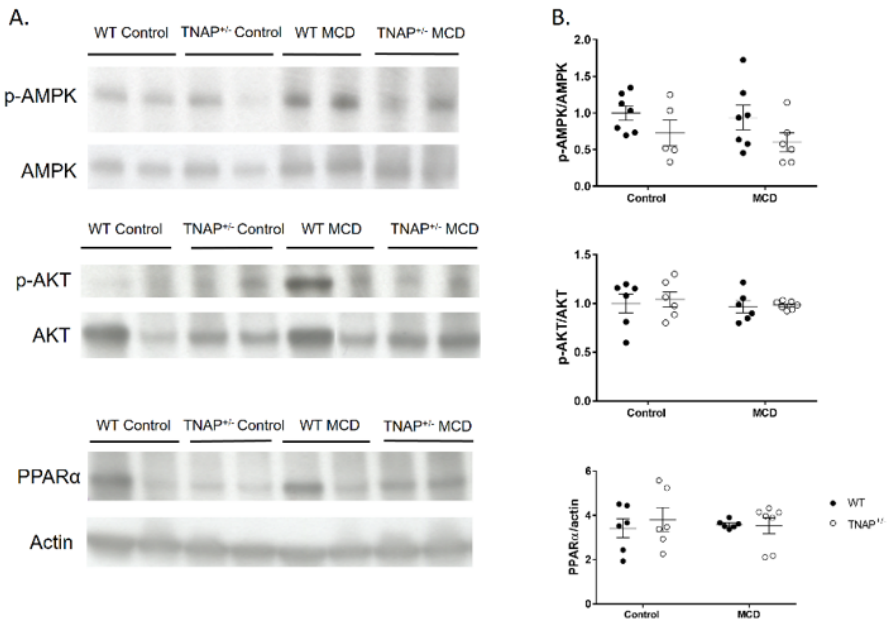
Figure 7. Hepatic ratio of p ‐ AMPK to AMPK, p ‐ AKT to AKT and PPAR α to actin in wild type (WT) and TNAP heterozy ‐ gous mice (TNAP +/ − ) fed a control diet (10% w/w fat, control) or the same diet deficient in choline and methionine (MCD). Western blot was used to analyze these parameters. ( A ) Western blot images. ( B ) Quantification. + p <